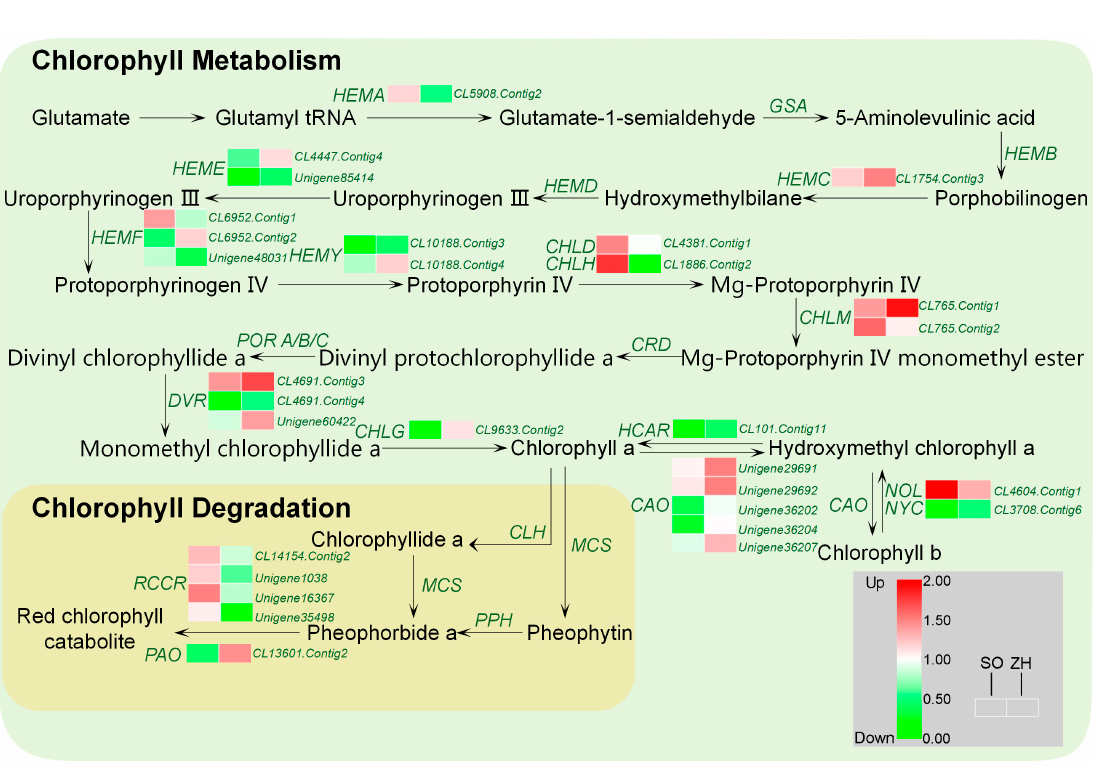
Figure 9. KEGG annotation of DEGs between ‘SO’ and ‘ZH’. ( A ) KEGG annotation of up-regulated DEGs; ( B ) KEGG annotation of down-regulated DEGs.